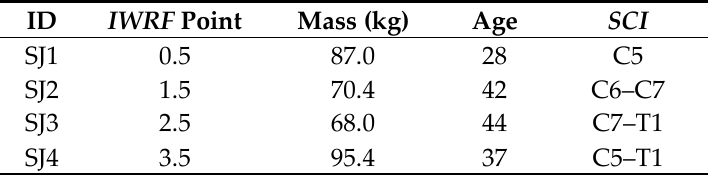
Table 1. Characteristics of the athletes participating at this work. IWRF point : classification point established by the International Wheelchair Rugby Federation. SCI : spinal cord injury